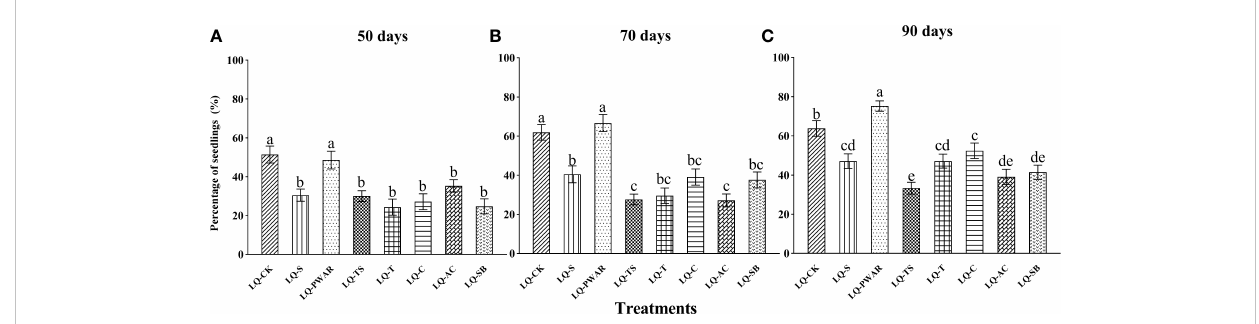
FIGURE 3 Effects of additional substances on seedling formation of seed-fungus complexes of Dendrobium of fi cinale with fungal strain LQ at (A) 50, (B) 70 and (C) 90 days after sowing. LQ-CK, seed-fungus complexes of D. of fi cinale with fungal strain LQ; LQ-S, 1% sucrose added; LQ-PWAR, 1% polymer water-absorbent resin added; LQ-TS, 1.5% tapioca starch added; LQ-T, 1% trehalose added; LQ-C, 1% chitosan added; LQ-AC, 0.1% activated carbon added; LQ-SB, 0.2% sodium benzoate added. The signi fi cant differences in the percentages of seedlings (mean±SE) among different treatments at 50, 70 and 90 days after sowing are shown by different lowercase letters at p <